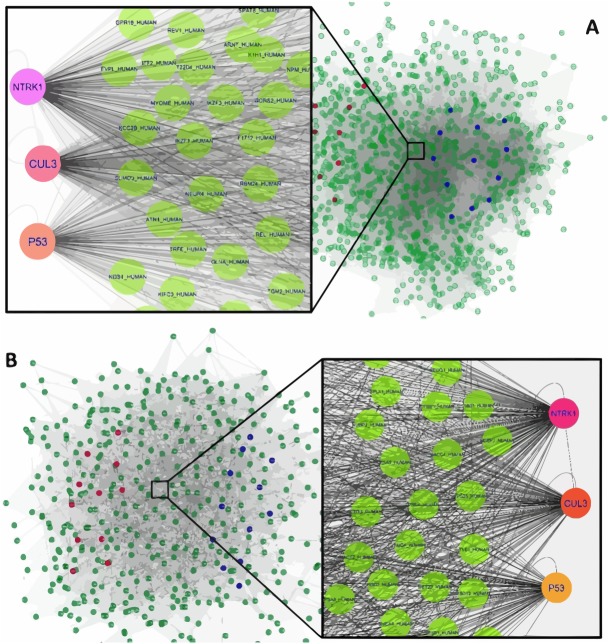
The constructed PPI network of the top up- and down-regulated DEGs in Men (A) and Women (B).Nodes denote proteins; edges denote interactions between two proteins. Red and blue nodes represent products of down- and up-regulated DEGs, respectively.